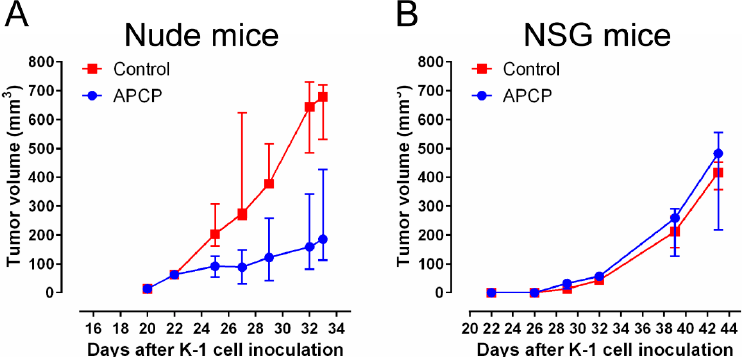
Figure 6. E ff ects of CD73 inhibitor on the growth of papillary thyroid carcinoma in xenografts. ( A ) K-1 cells (1 × 10 6 ) were inoculated subcutaneously into BALB / c nude mice. When tumor size reached 5